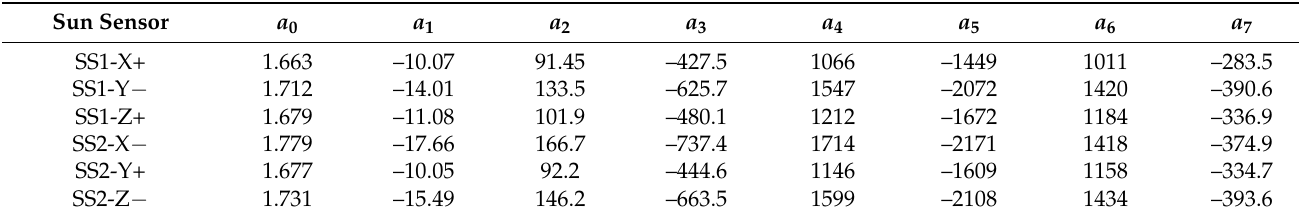
Table 4. Coefficients of Equation (16), used for modeling the angle, α , of the Sun irradiance in relation to each one of the UPMSat-2 photodiodes from the SS1 and SS2 sun